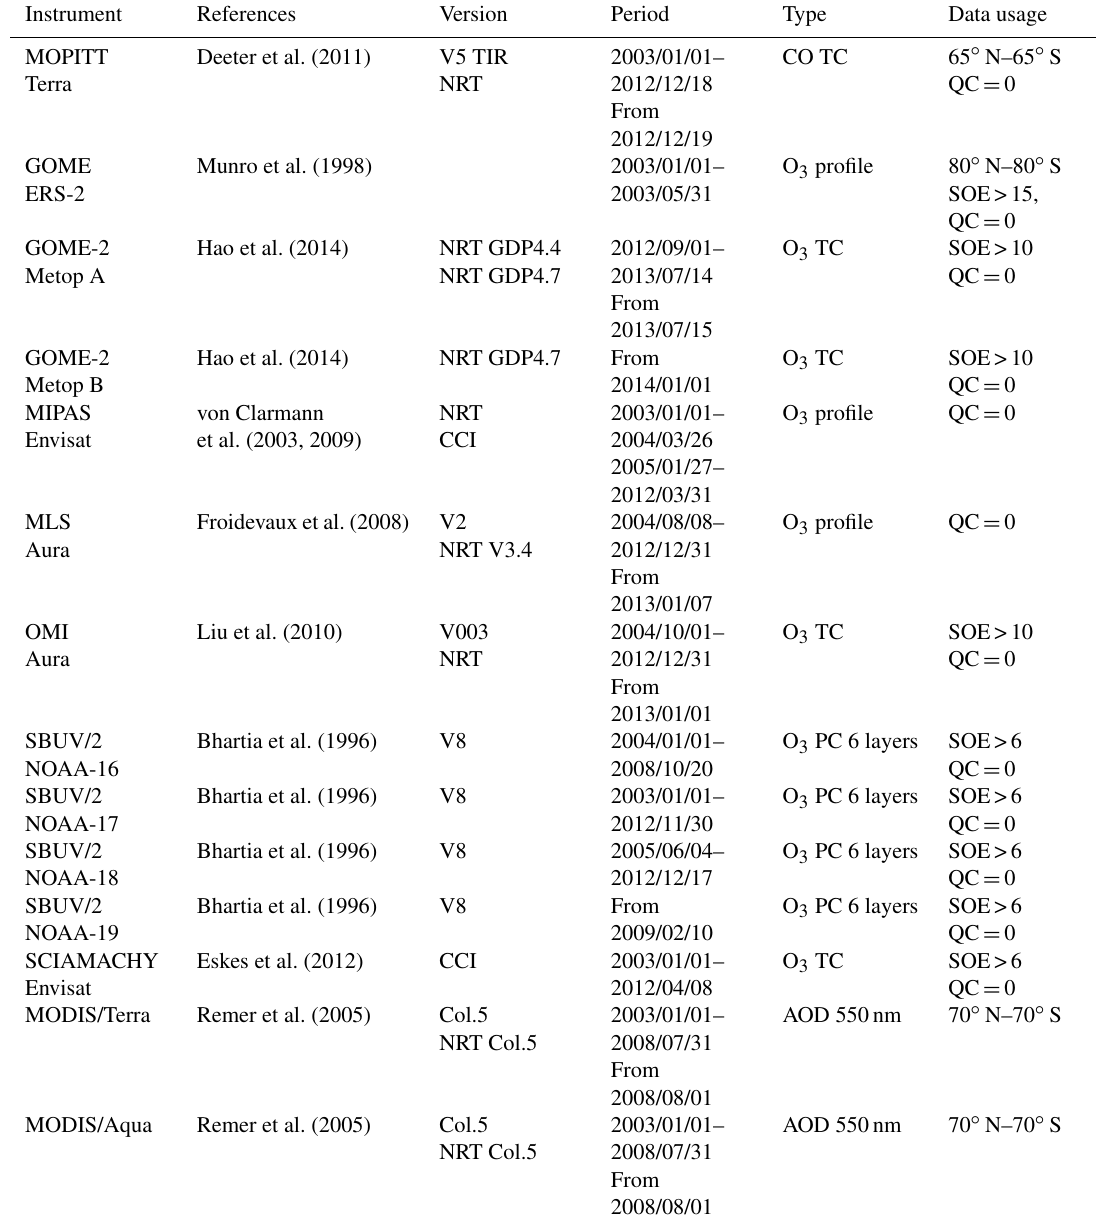
Table 2. Assimilated satellite observations in